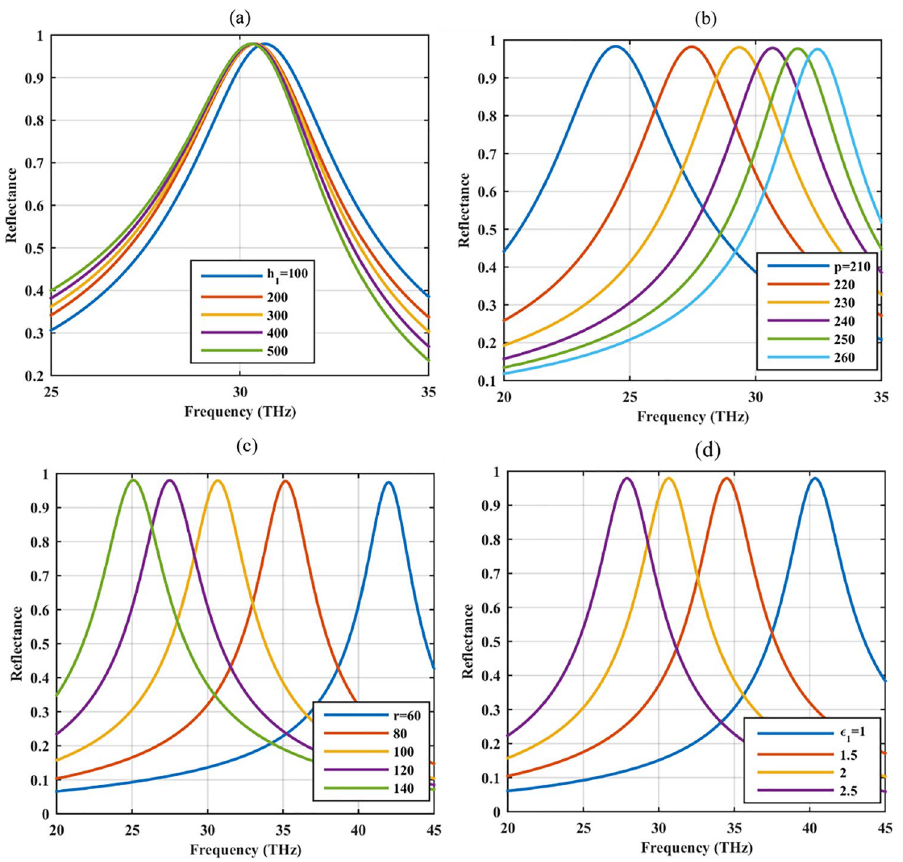
Figure 3. Reflectance of the graphene-coated hole array for different geometrical and material parameters ( a ) substrate height